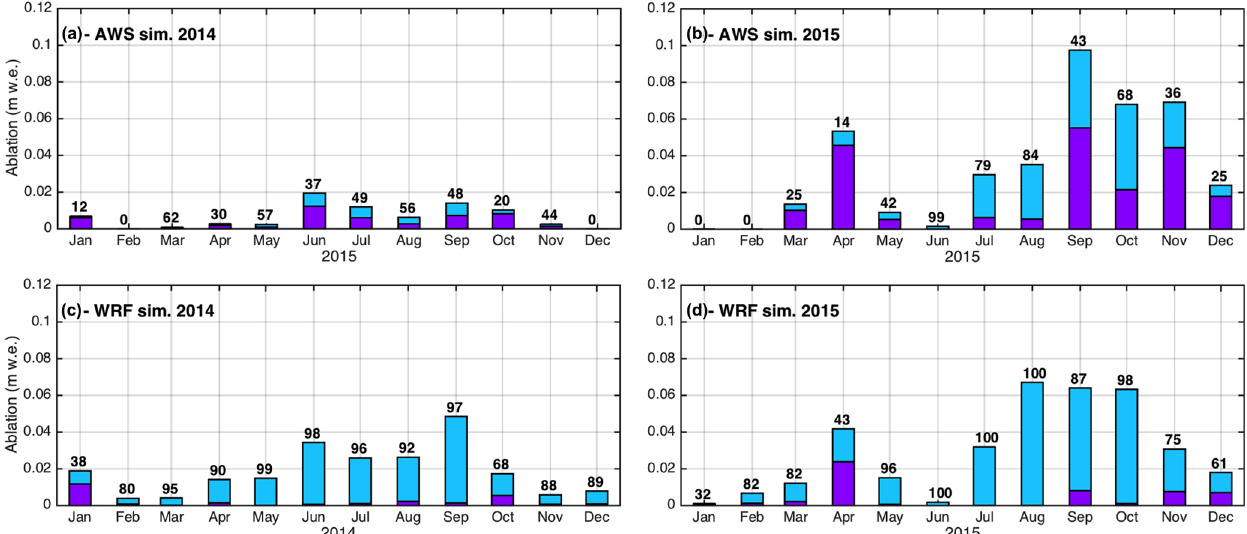
Figure 10. Stacked simulated melt (purple) and sublimation (blue) per month using AWS forcing (a, b) and WRF forcing (c, d) . Black numbers indicate the monthly sublimation ratio in percent.